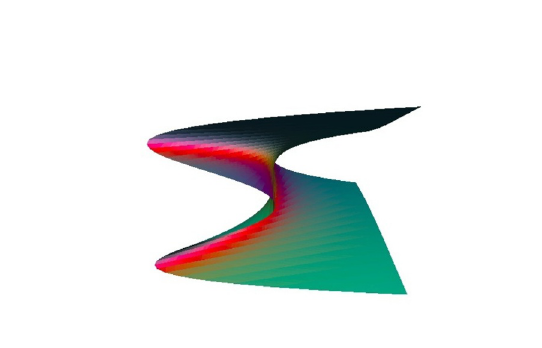
Figure 5 . Smooth degree four cover of the